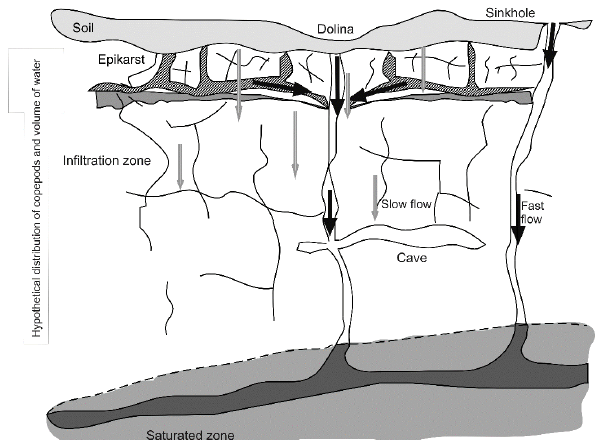
Figure 1. Conceptual model of epikarst. Gray arrows indicate the direction of slow water flow and black arrows are faster flow paths. From [18]. Used with permission of ZRC SAZU, Založba ZRC.